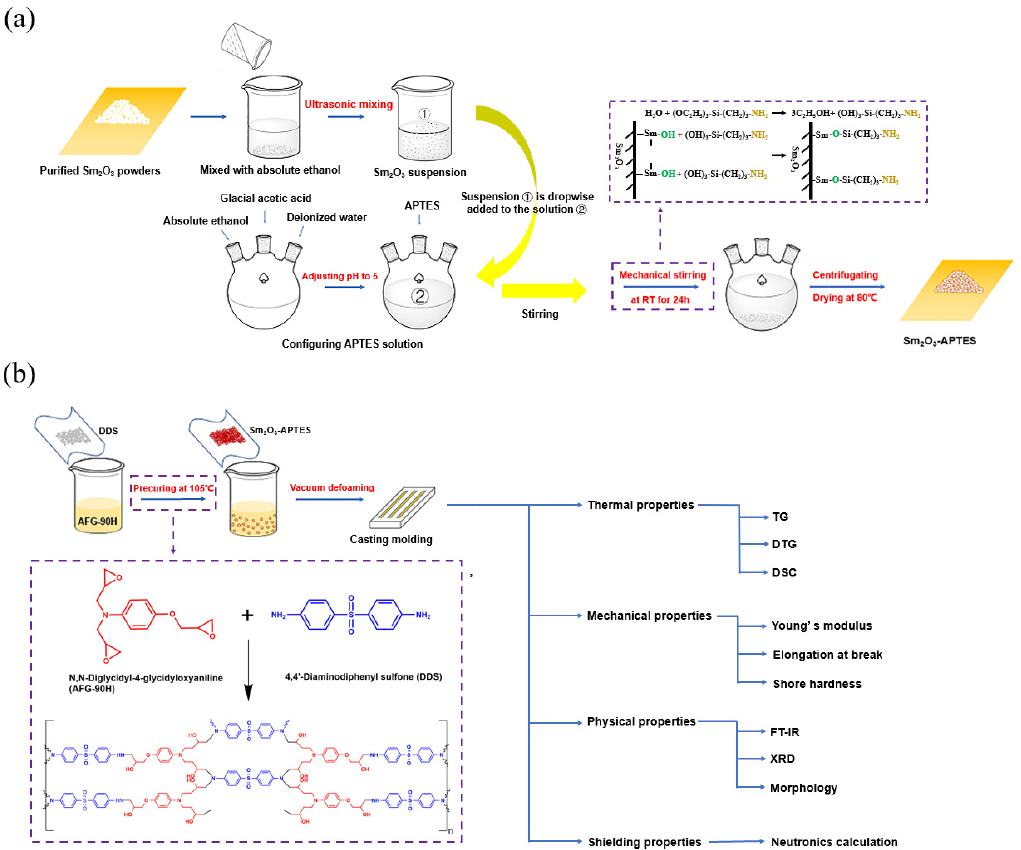
Figure 2. Schematic diagrams of modification process and curing progress: ( a ) scheme of the procedure for the preparation of Sm 2 O 3 -APTES; ( b ) diagram of curing reaction of N , N -diglycidyl-4- glycidyloxyaniline and 4,4 (cid:48) -aminodiphenyl